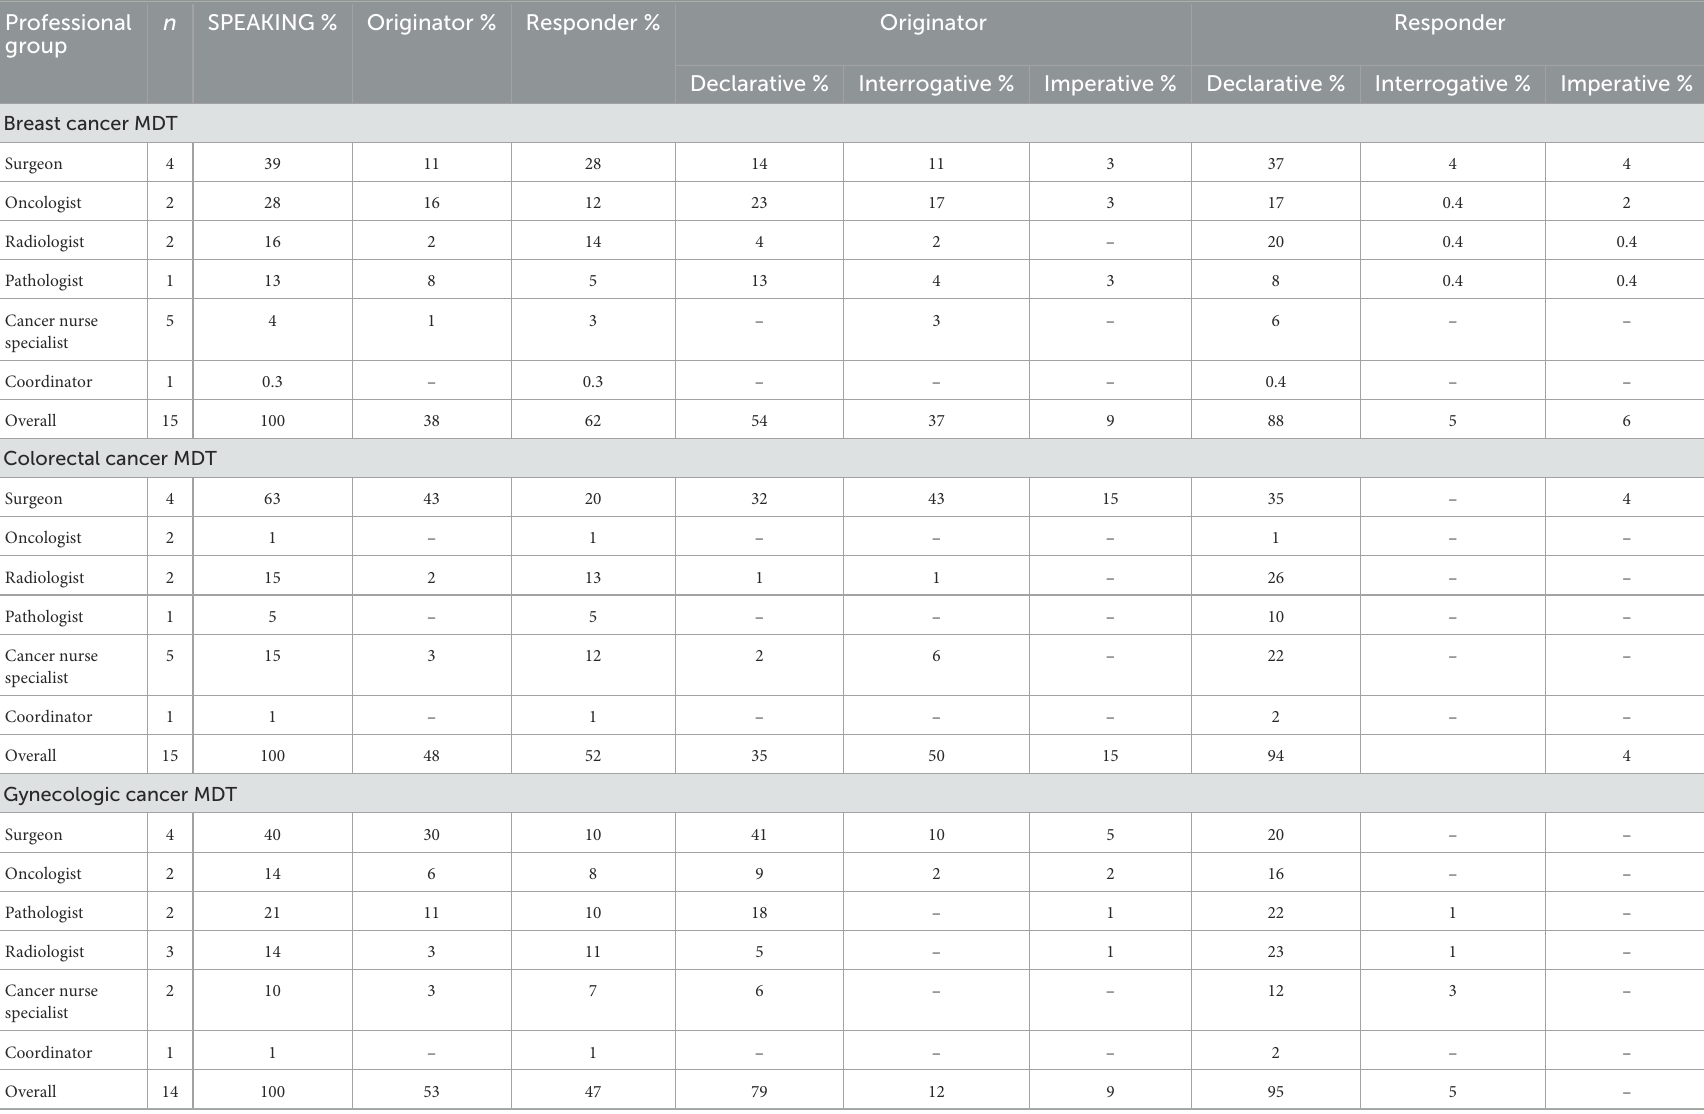
TABLE 4 Communication style by professional group across participating cancer multidisciplinary teams (MDTs). Professional